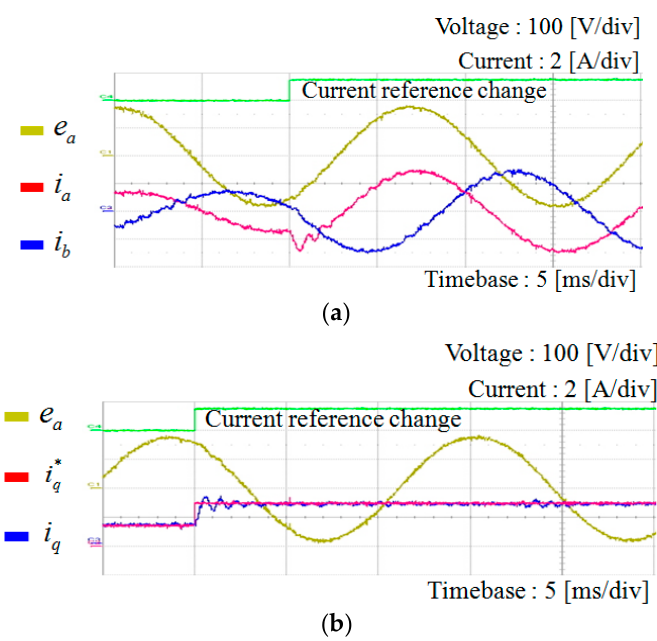
Figure 19. Experimental results of the proposed control scheme under the step change in current reference. ( a ) a -phase and b -phase current responses; and ( b ) q -axis current response.